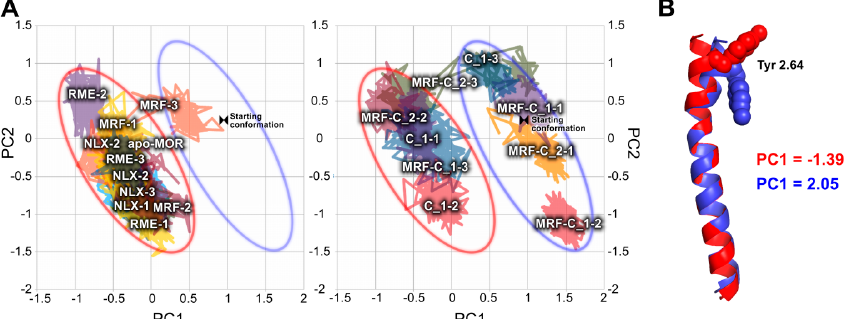
Figure 5. PCA of TM2. ( A ) Conformational space occupied by investigated complexes through last 50 ns of simulations in a common space. For clarity, data is split into two panels. Left panel: complexes with orthosteric ligand only; right panel: complexes containing compound 1 or compound 2 . Ellipses were added to the graphs to facilitate comparison. Color-coding of ellipses corresponds to the part B of the figure. ( B ) Projections of extreme PC1 values on trajectories, depicting main conformational differences between groups presented in the part A of the figure. Color-coding of the legend corresponds to colors of the helices.